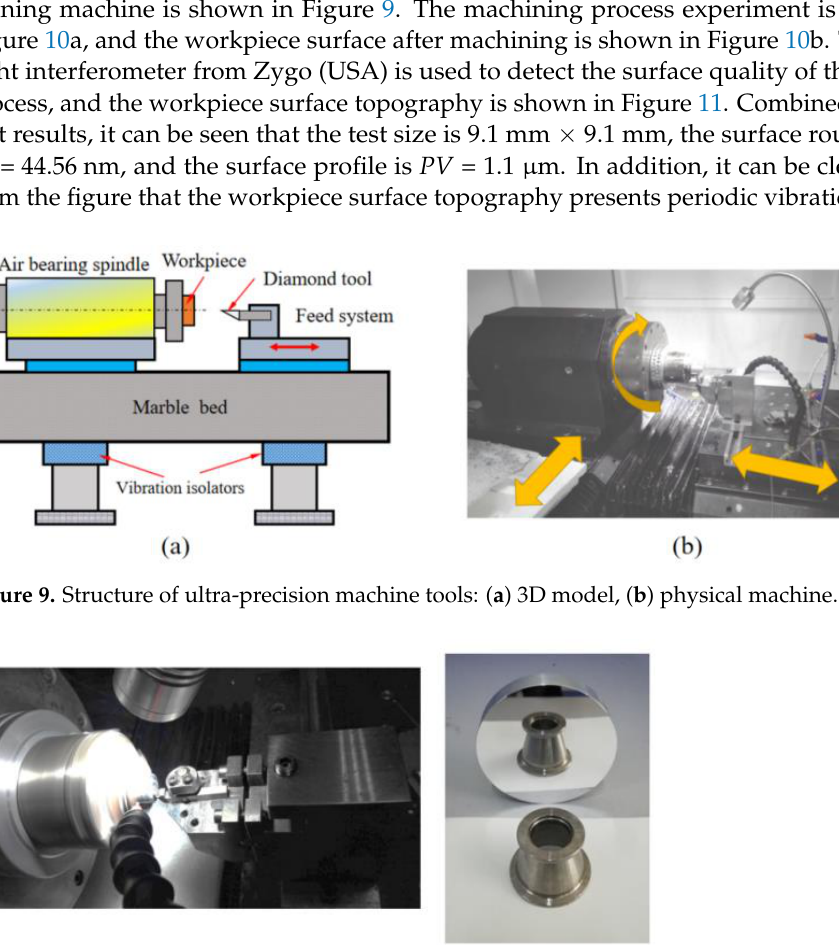
Figure 10. ( a ) Turning experiments of the workpiece surface and ( b ) the machined workpiece sur- face.